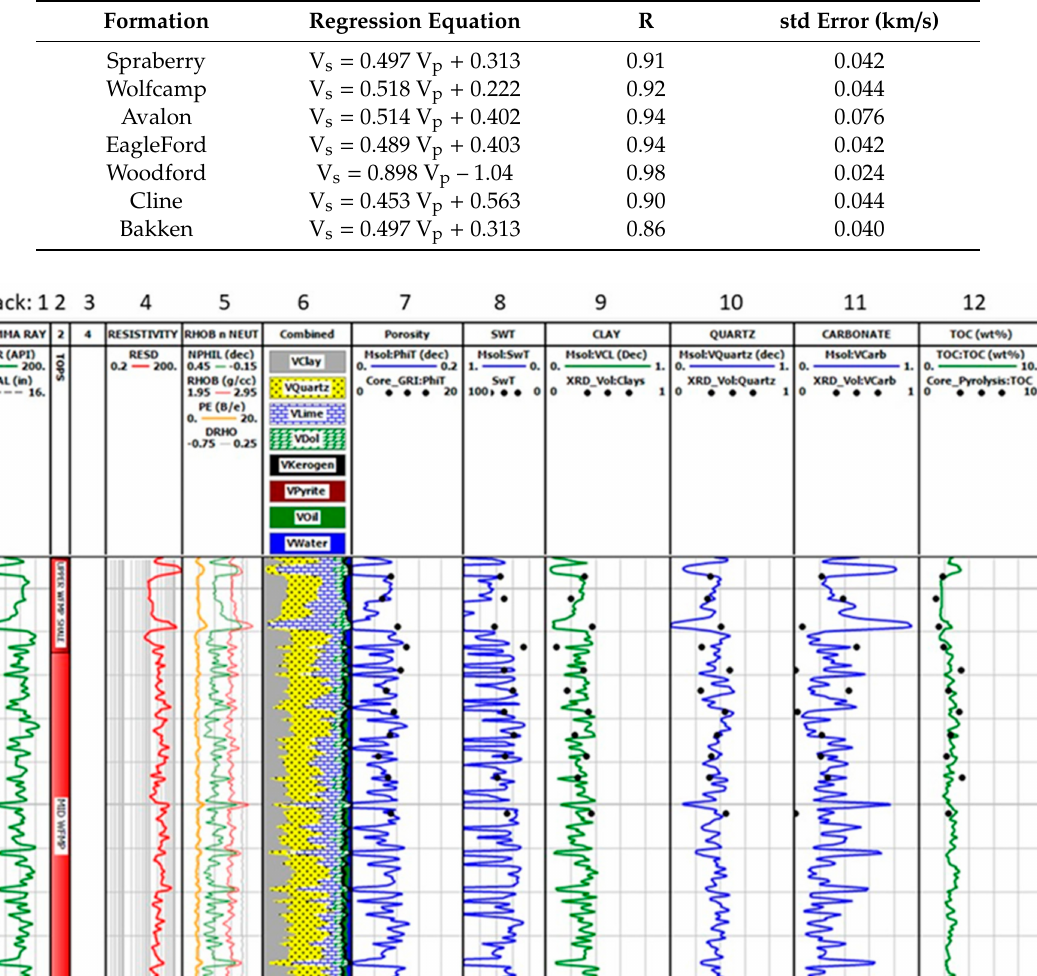
Table 3. Shear-wave velocity (V s ) versus compressional-wave velocity (V p ) relationships by formation. Velocities are in km / s. R is the correlation coe ffi cient and std error is the standard deviation of the prediction residual. The F-test was greater than 100 and the sig F statistic was virtually zero in all cases. The trends are similar excepting the Woodford shale which can be explained as a binary sequence of layers alternating between siliceous and organic mudrock. Velocities are in units of km / s.